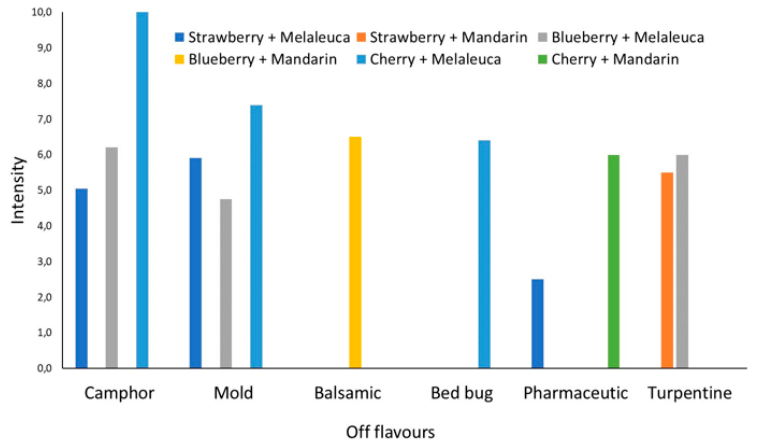
Figure 5. Intensity of off-flavors (camphor, mold, balsamic, bed bug, pharmaceutic, turpentine) attributed by panelists to the essential-oil-dipped fruits (strawberries and blueberries) evaluated on an intensity scale of 0-10. Melaleuca, Melaleuca alternifolia ; Mandarin, Citrus reticulata .